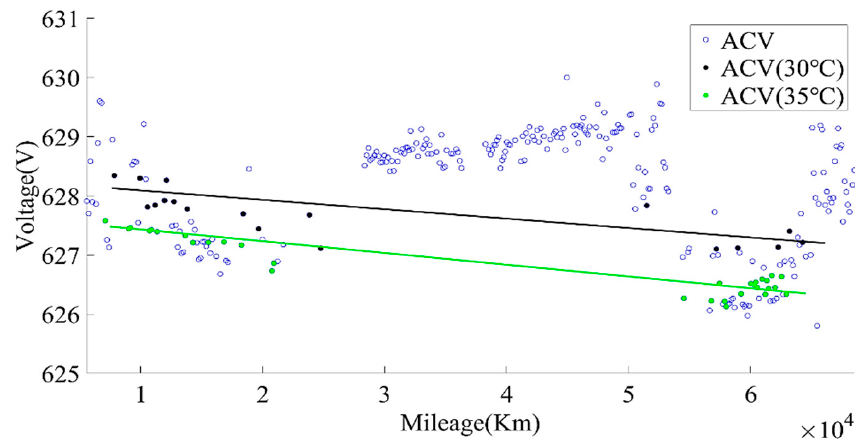
Figure 7. The relationship between pack voltage and the mileage.